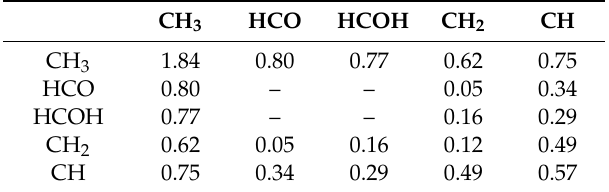
Table 3. Comparison of the activation energies of main coupling